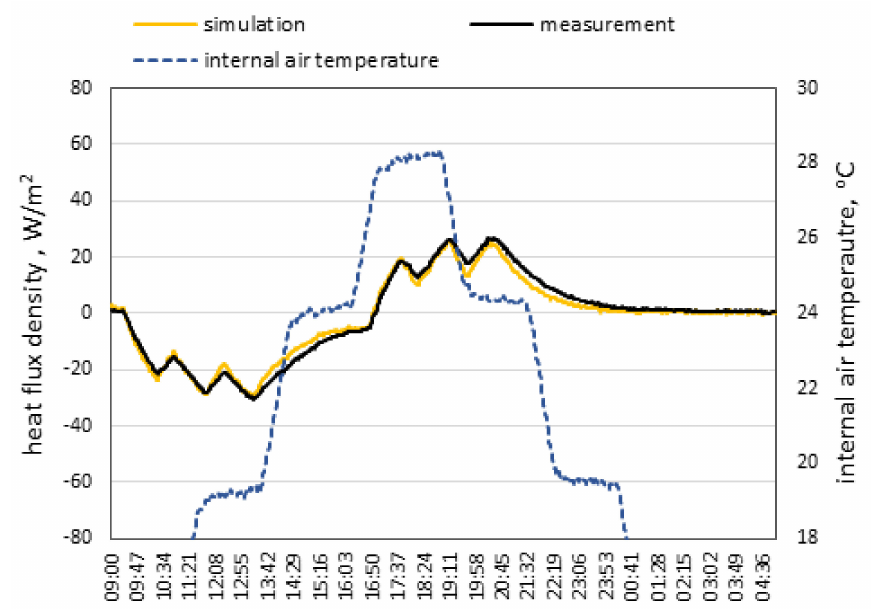
Figure 6. Measured versus simulated heat flux density on the internal surface of the standard gypsum